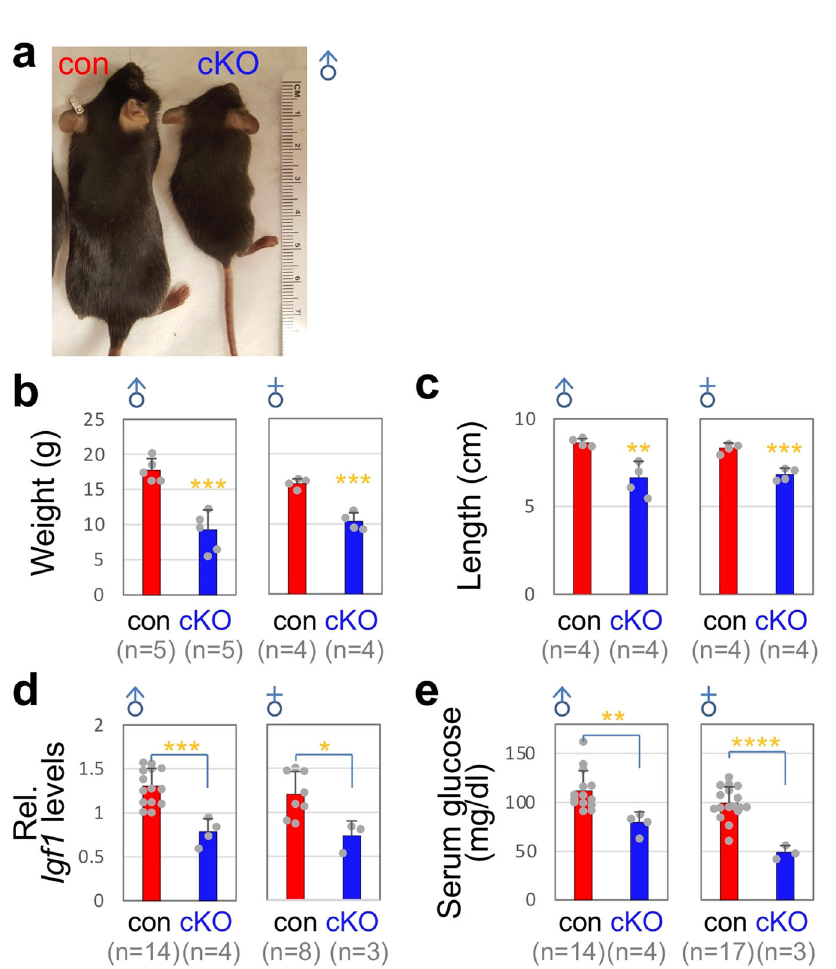
Fig. 3 Dwar fi sm of Mll4 -cKO mice. a Mll4 -cKO mice are smaller than their littermate control mice (a representative image for males). b – e A signi fi cant reduction in body weight ( b ), linear length ( c ), liver Igf1 mRNA levels ( d ), and serum glucose levels ( e ) in male and female Mll4 -cKO mice relative to their littermate control mice at P40. The number of mice used is as indicated below each genotype in parenthesis ( b – e ). Statistical differences were determined by two-sided Student ’ s t -test; * p < 0.05, ** p < 0.01, *** p < 0.001, and **** p < 0.0001. Column bars represent mean, error bars indicate the SD ( b – e